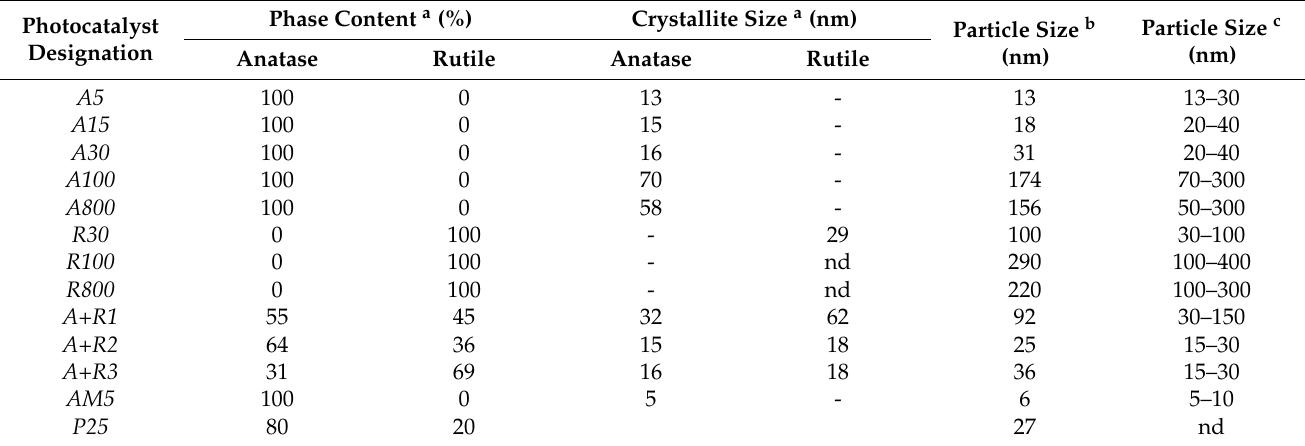
Table 1. Structure and texture properties of photocatalysts used for ampicillin degradation.